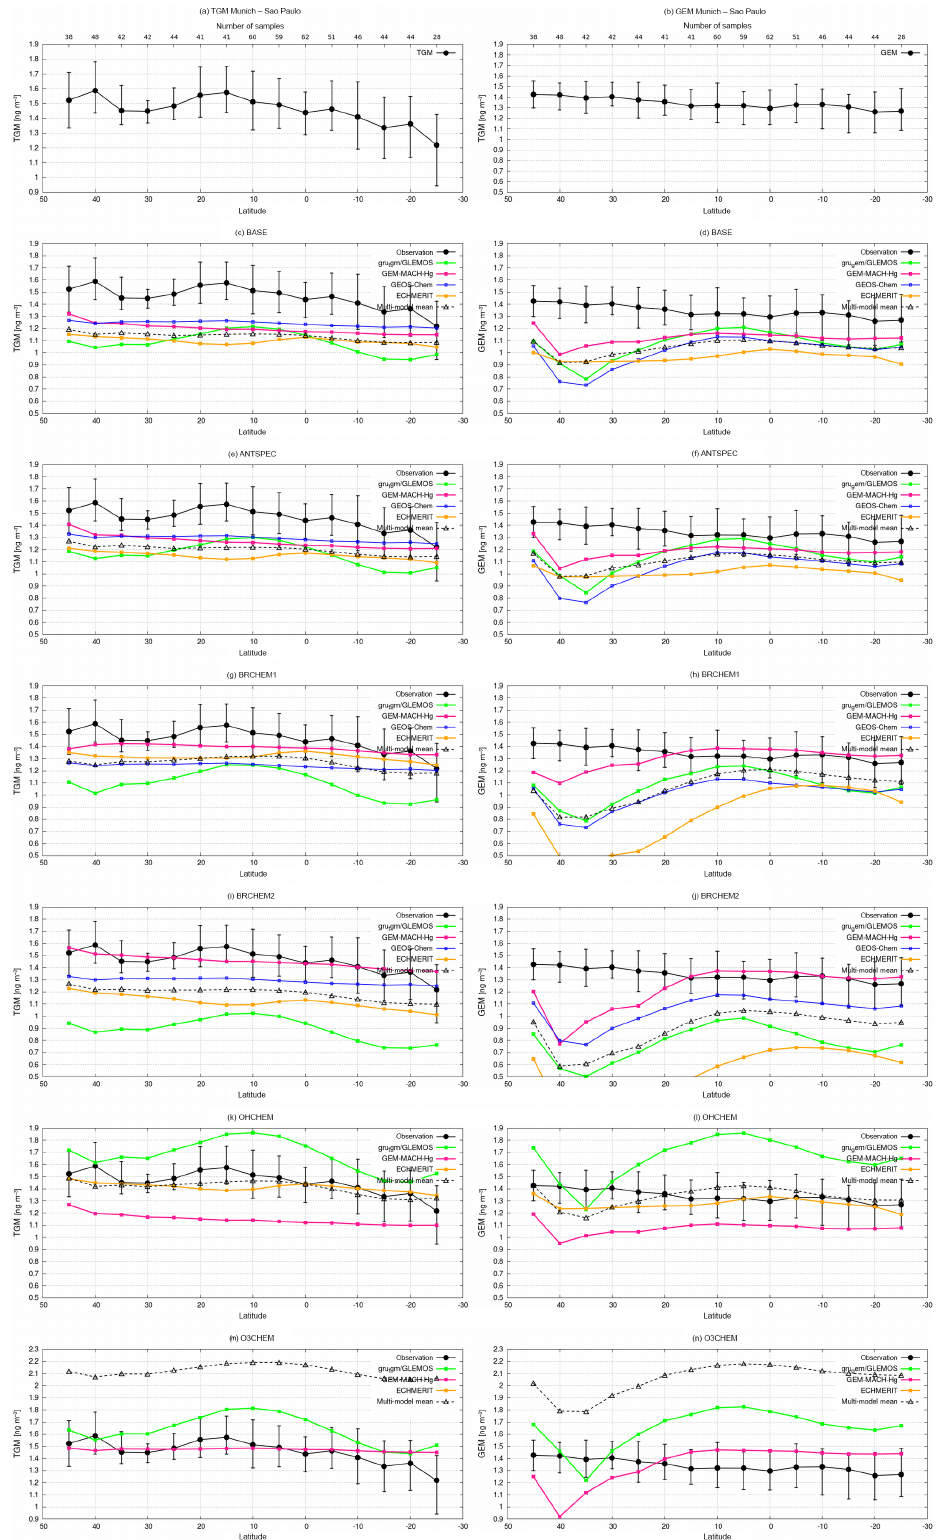
Figure 14. Average interhemispheric transects for 19 flights from Munich to Sao Paulo. TM (left side) was measured on the outward and GEM (right side) on return flights (Slemr et al., 2014). Error bars indicate the 66% quantile range of all observations for a given